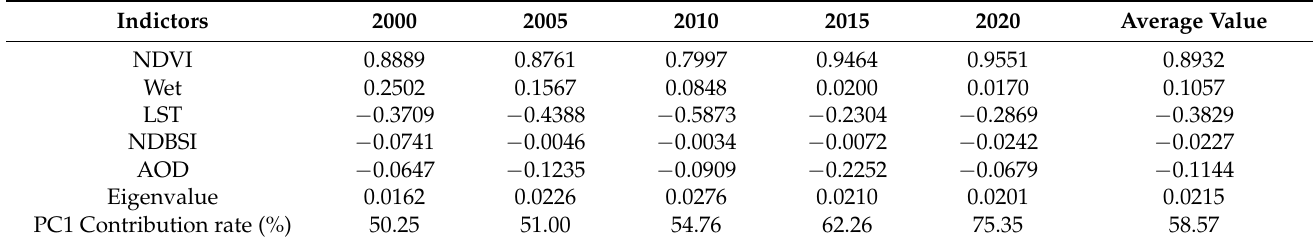
Table 3. Results of the PC1 analysis.